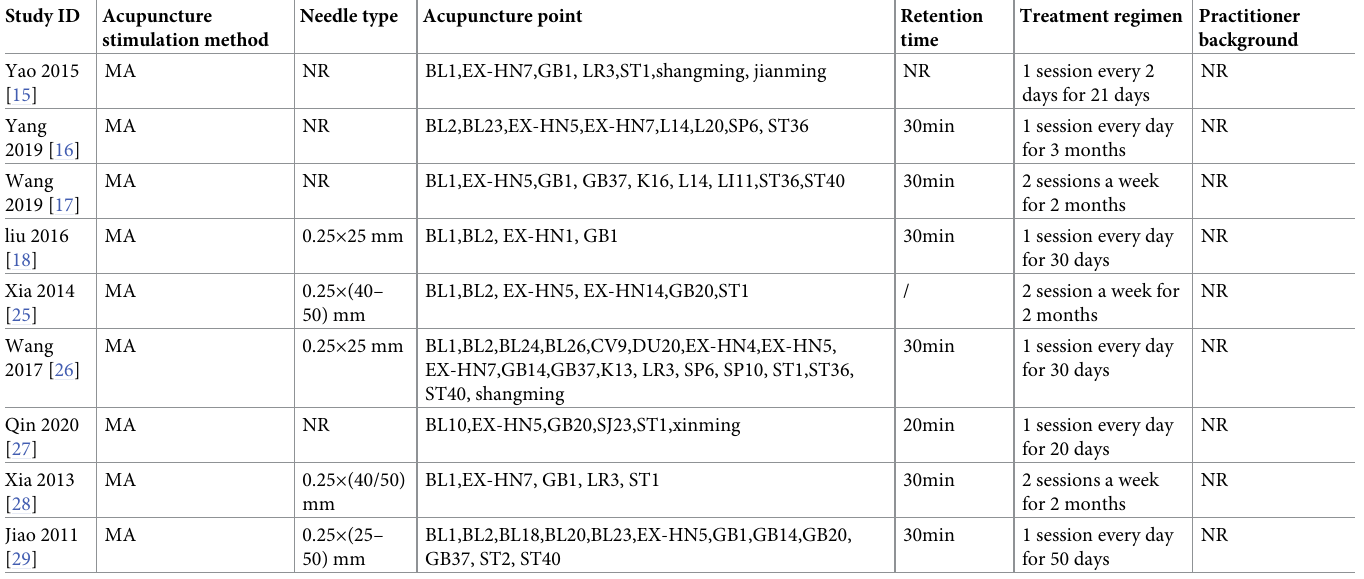
Table 2. Descriptions of acupuncture